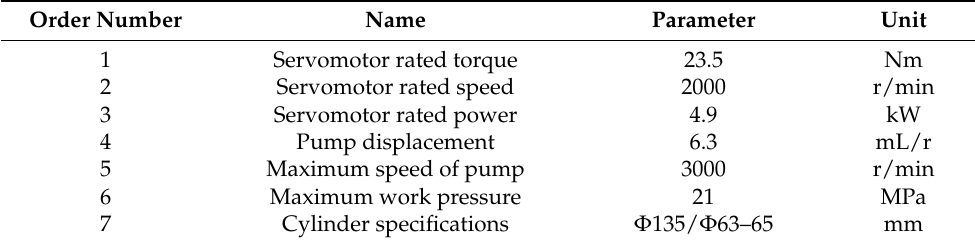
Figure 6. The test operation platform for the PCSM. The working parameters of the PCSM test platform are shown in Table 1. Table 1. Test platform parameter table. Table 1. Test platform parameter table.